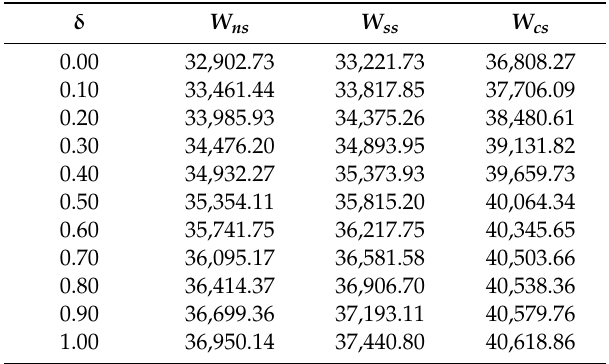
Table 7. Total utility of the supply chain under di ff erent